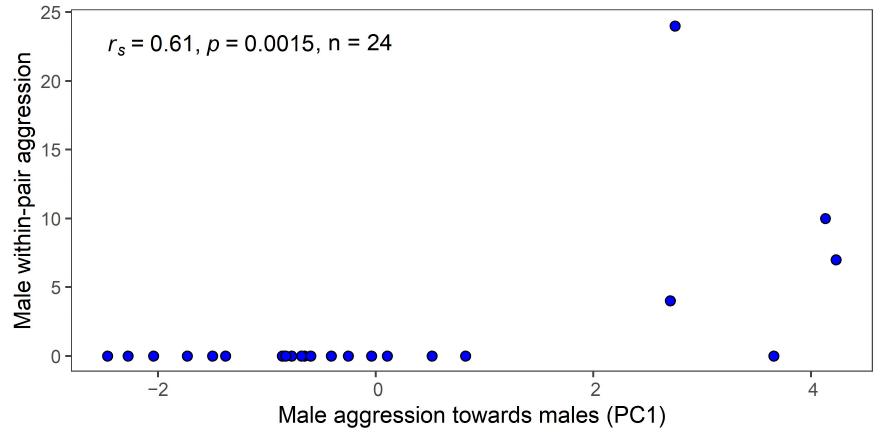
Figure 2. Scatterplot showing the relationship between the number of male within-pair attacks and male–male aggression based on PC1 (N Male = 24). The Spearman correlation coefficient and p -value are shown in the top left corner.